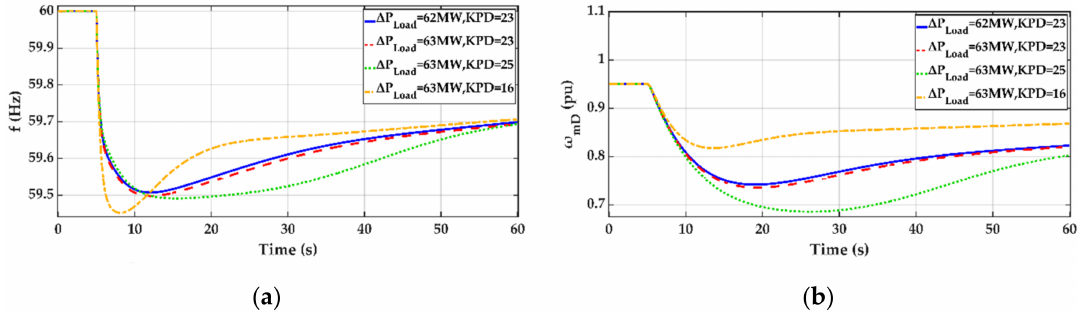
Figure 3. Dynamic response curves for the system subject to a load increase of ∆ P Load = 62 MW and 63 MW (wind penetration = 29.4% and V W = 11 m/s). ( a ) Frequency and ( b ) DFIG speed.